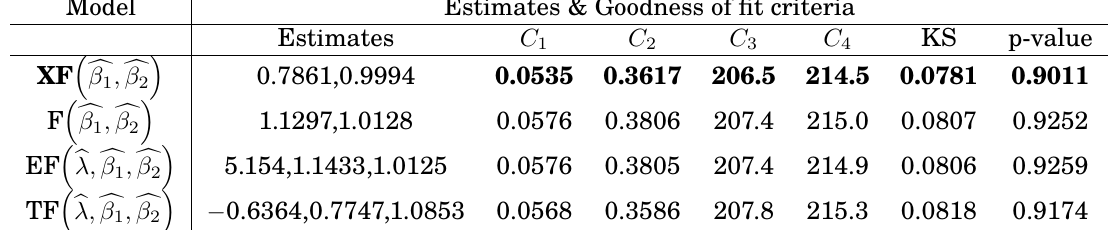
Table 5: Estimates, C